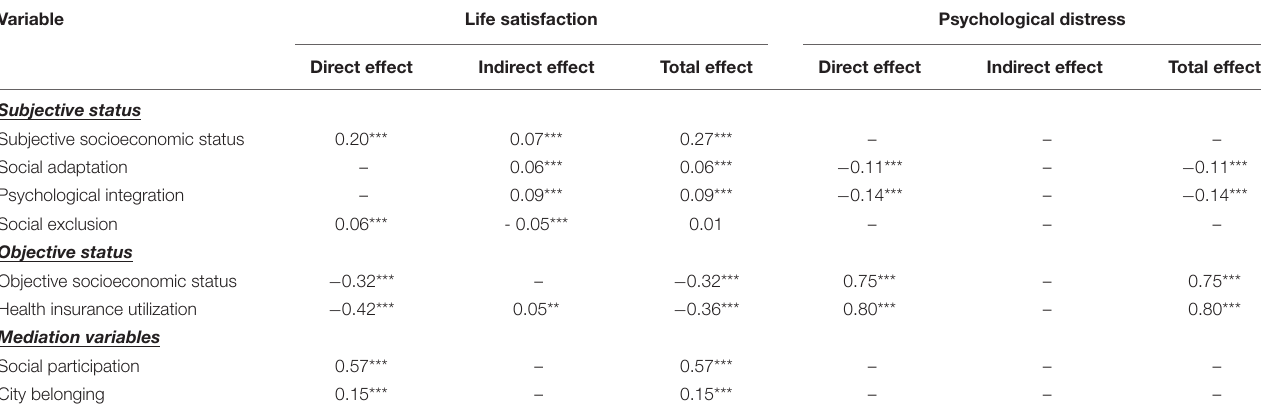
TABLE 4 | Direct and indirect effects of socialization factors on life satisfaction and psychological distress in young migrants.